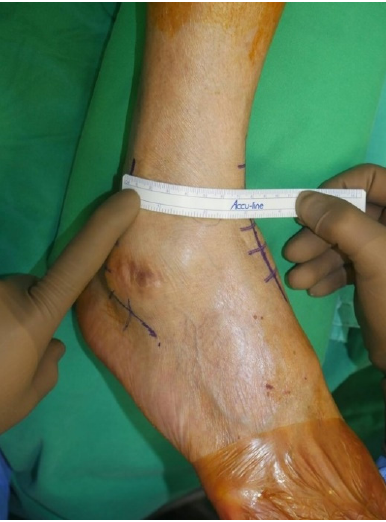
Figure 2. An 8 to 10 cm lateral incision was made along the posterior border of the lateral malleolus